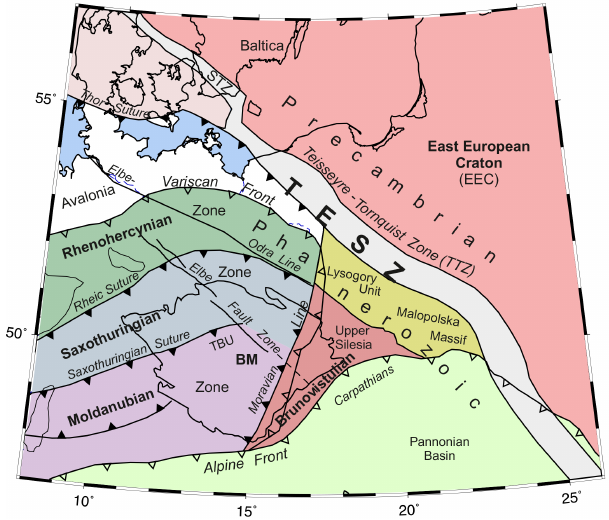
Figure 2. Seismic stations of the passive experiment PASSEQ (2006–2008) designed to study upper mantle structure of the TESZ. Labels are assigned to some of stations for easier